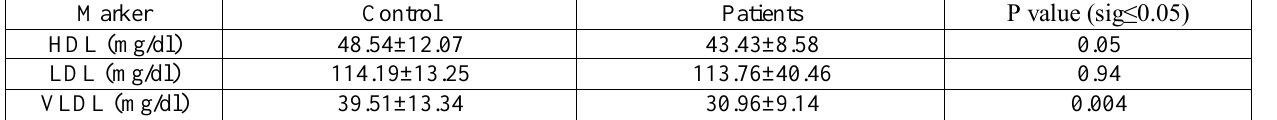
Table 6: HDL, LDL, and VLDL levels in patients and control groups.